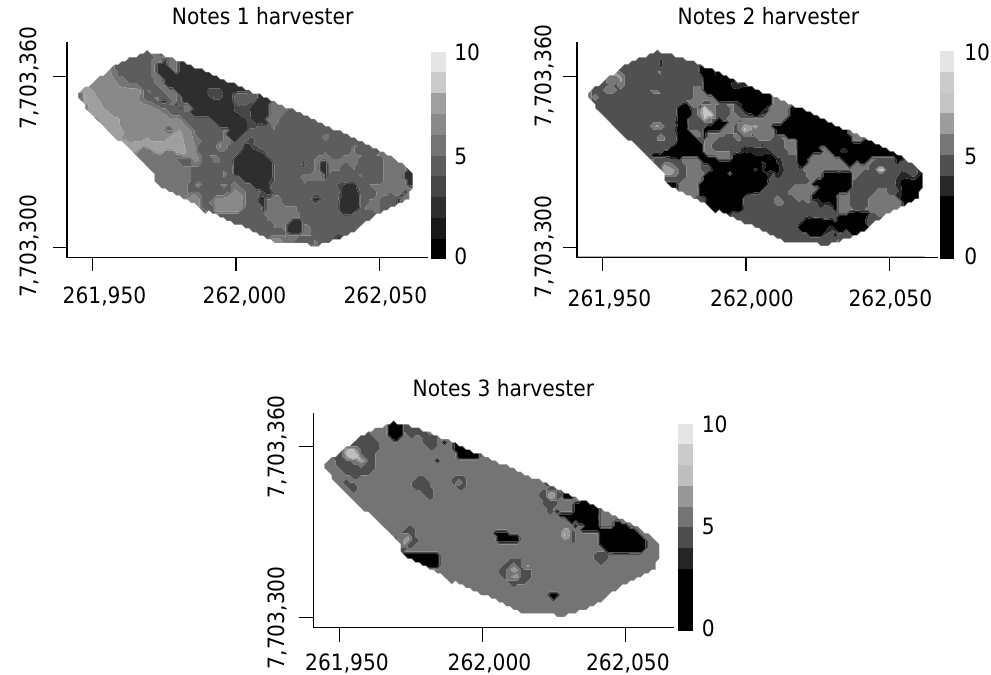
Figure 9. Fuzzy classification maps based on the application needs of nitrogen, phosphorus, potassium and liming on the three crops.